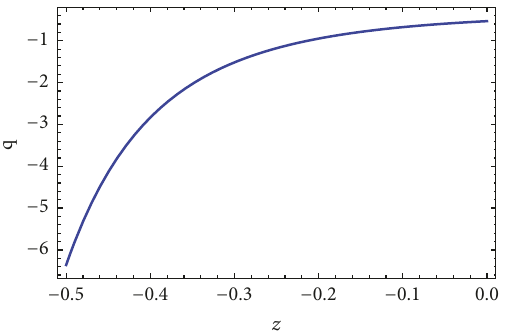
Figure 2: Evolution of EoS parameter versus 𝑧 for 𝜆 = 2.4 . Figure 3: Evolution of deceleration parameter versus 𝑧 for 𝜆 = 2.4